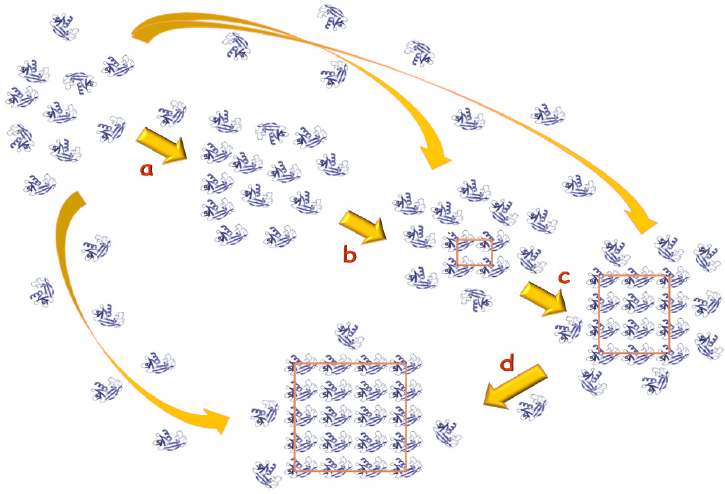
Figure 1. Fluid aggregate model. Increasing supersaturation promotes molecule association, which begins to organize into large disordered aggregates ( a ) molecules within the cores of such aggregates reorient, redistribute and form more geometrically rigorous interactions; ( b ) These latter interactions tend to order and stabilize the aggregate core, which increases to produce a critical nucleus; ( c ) This ultimately develops into a true crystal; ( d ) Free molecules are then adsorbed to the crystal surface and increase its size by their incorporation into its lattice.